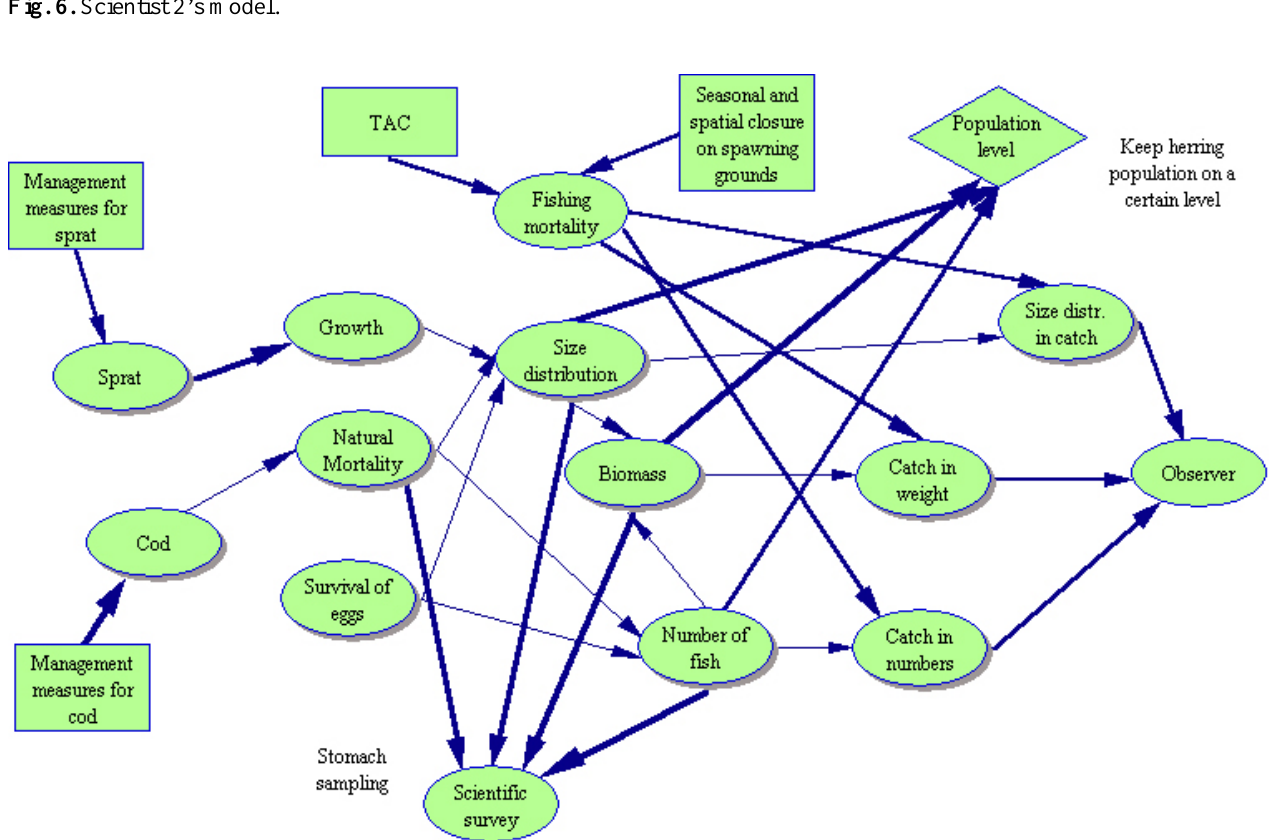
Fig. 6. Scientist 2’s